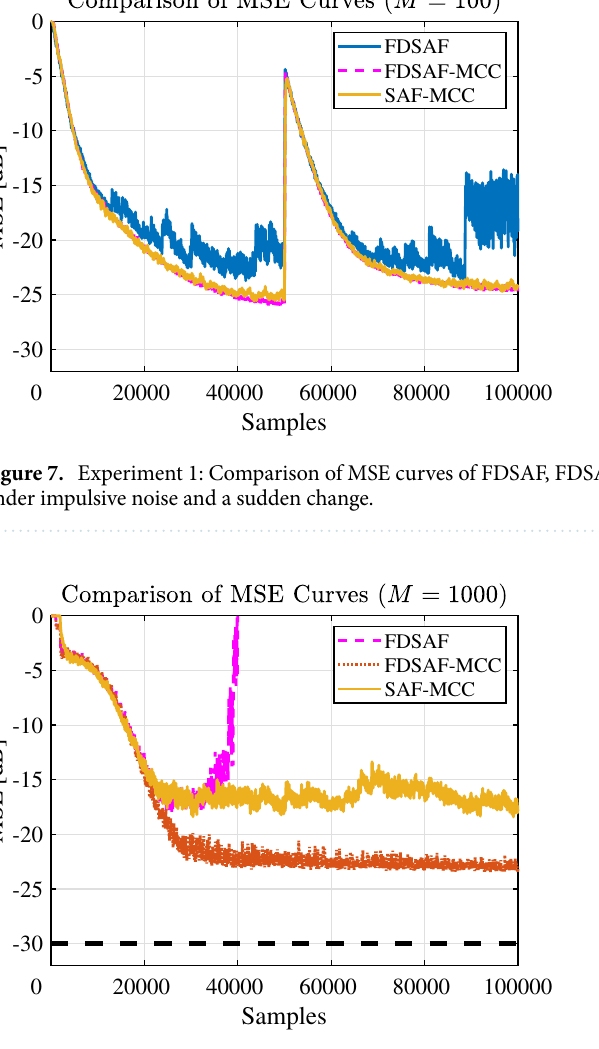
Figure 8. Experiment 2: MSE curves of FDSAF, FDSAF-MCC, and SAF-MCC under impulsive